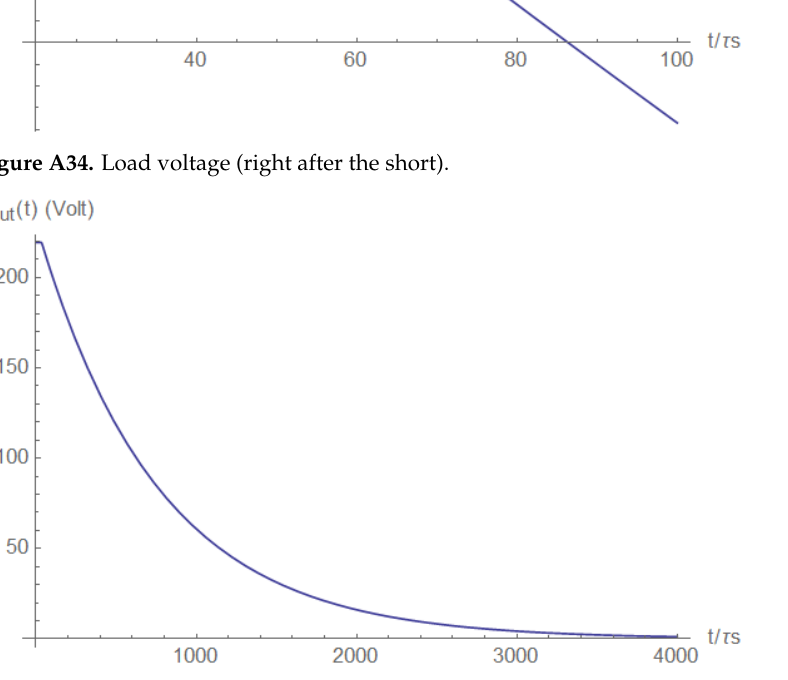
Figure A35. Load voltage (after some time). The first and the second load voltage derivatives are shown in Figures A36 and A37. In this case, the desirable pulse shape was obtained for the second